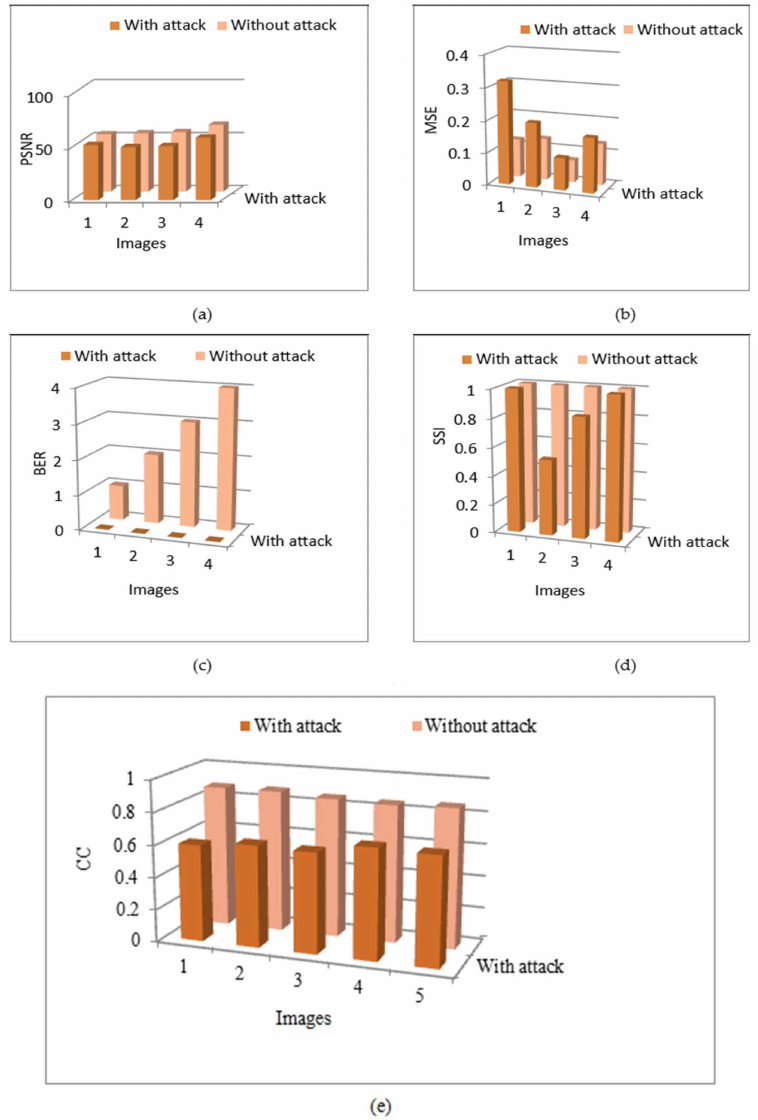
Figure 8. ( a ) Attack versus without an attack of PSNR. ( b ) Attack versus without an attack of MSE. ( c ) Attack versus without an attack of BER. ( d ) Attack versus without an attack of SSI. ( e ) Attack versus without an attack of